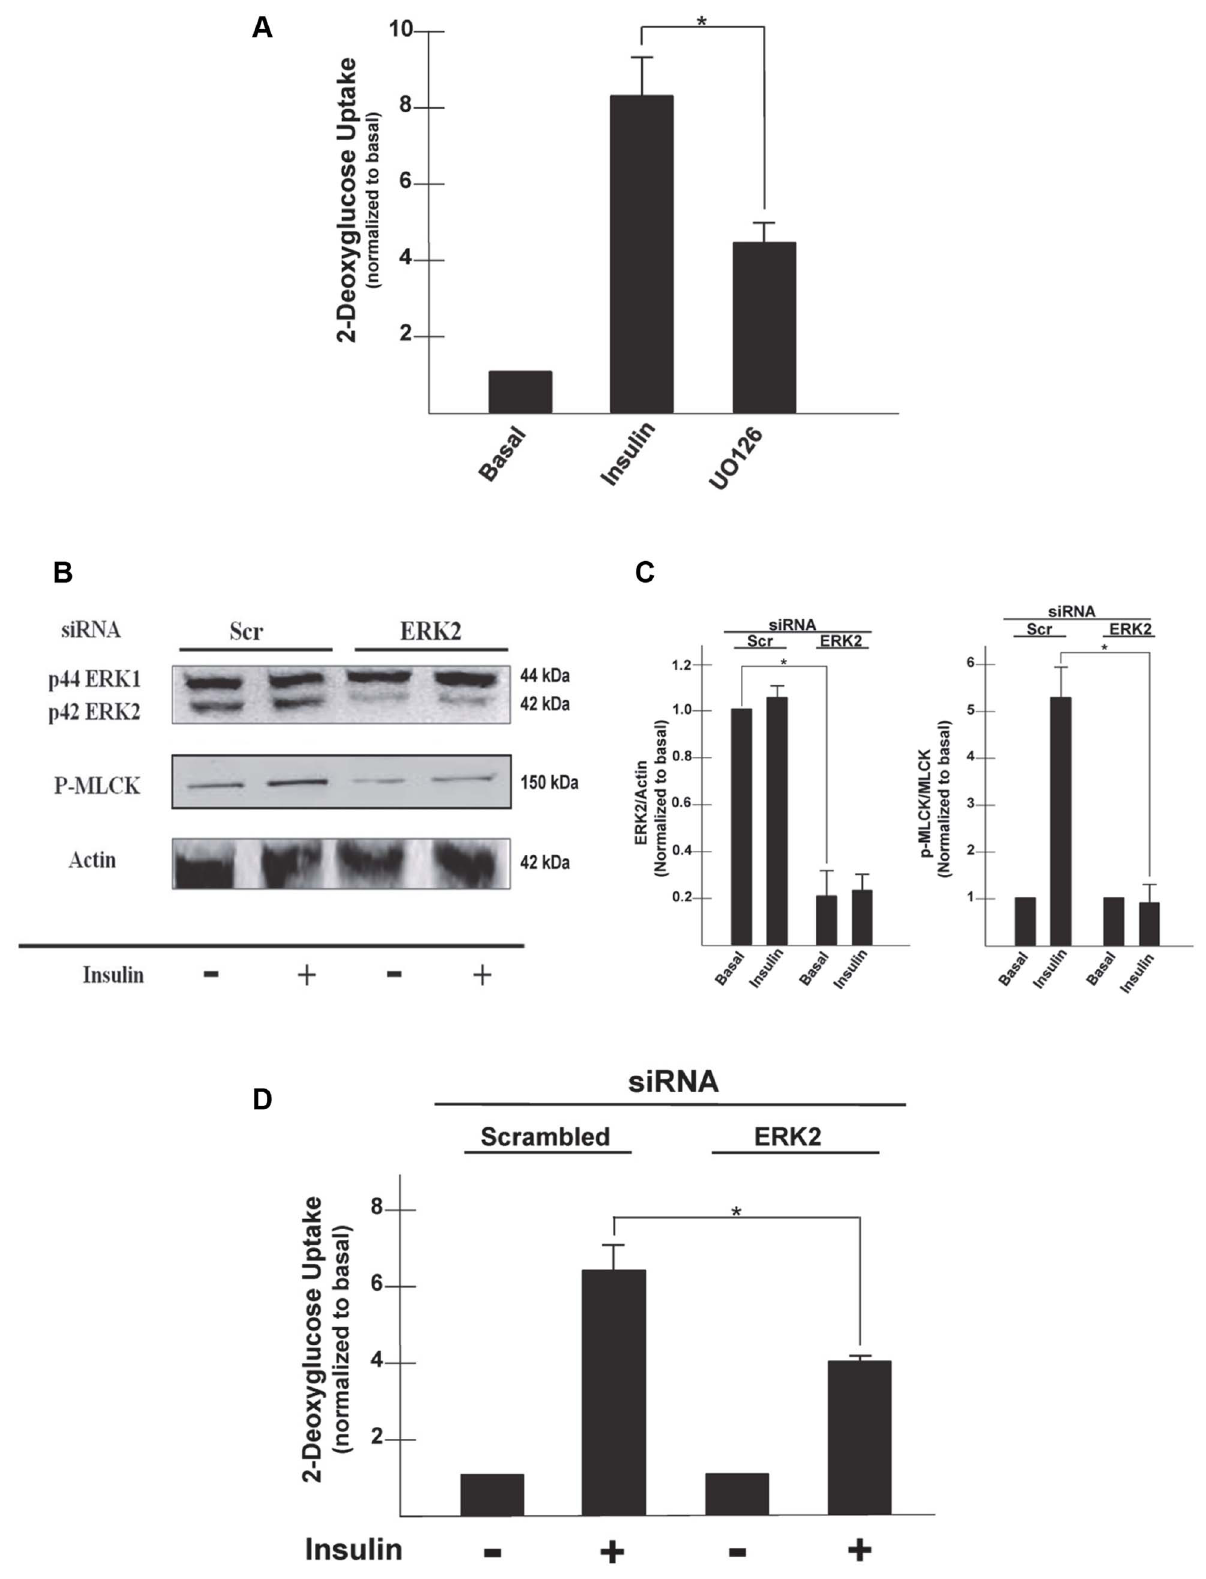
Figure 4. ERK is required for MLCK phosphorylation and insulin-stimulated glucose uptake. Serum starved 3T3-L1 adipocytes were pretreated with U0126 (25 m M) for 15 min and then either left untreated or stimulated with insulin (100 nM) for 20 min. (A) Untreated (Basal) or insulin stimulated (100 nM) adipocytes were incubated with [1- 14 C]-2-deoxy-D-glucose (0.1 m Ci/well) and 5 mM glucose for an additional 10 min. Cells were then lysed and glucose uptake calculated as disintegrations per mg protein and expressed as percent of control. Results are the mean 6